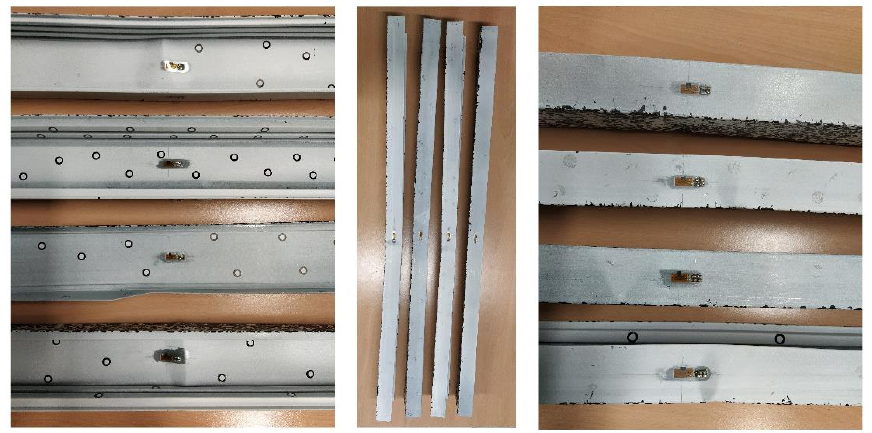
Figure 16. Mechanisms of failure of tested columns. The most favourable cross-section in terms of axial compressive force is that of col- umn B3. The web and flange displacements, obtained from the optical method, for this column are shown in Figure 17.